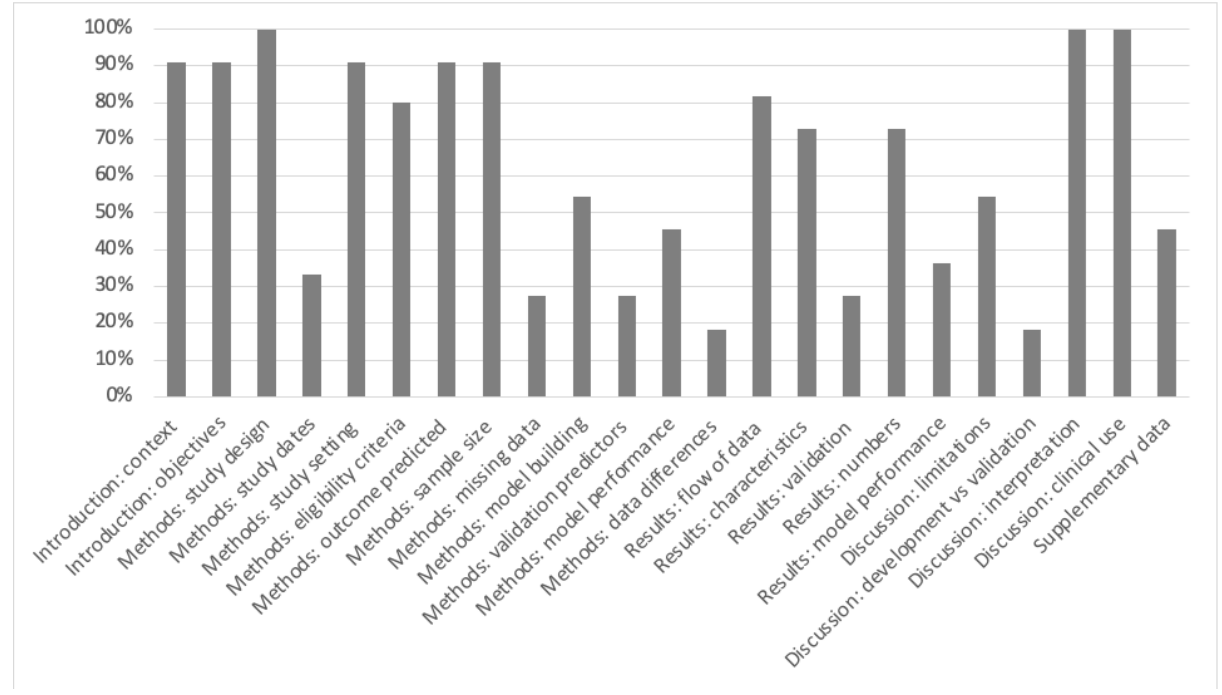
Figure 2. Adherence of studies to reporting